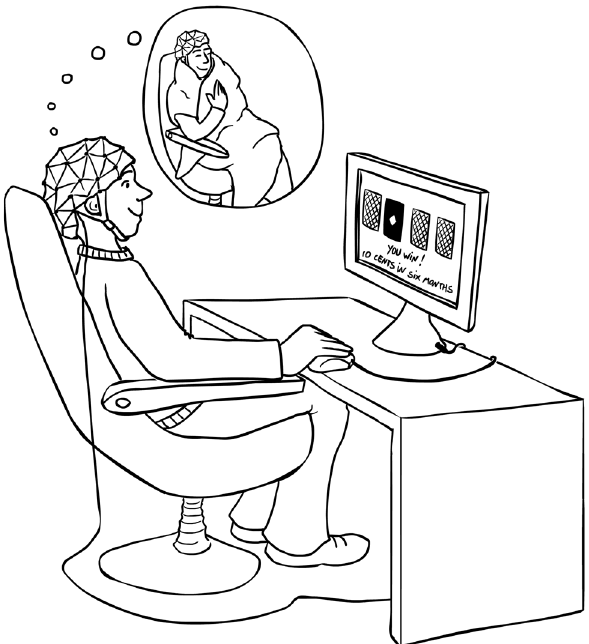
Figure 1. Illustration of the suggestion of safety involving an image of being cuddled into a blanket. This figure was drawn by Anne Rasch https ://annek arenr asch.blogs